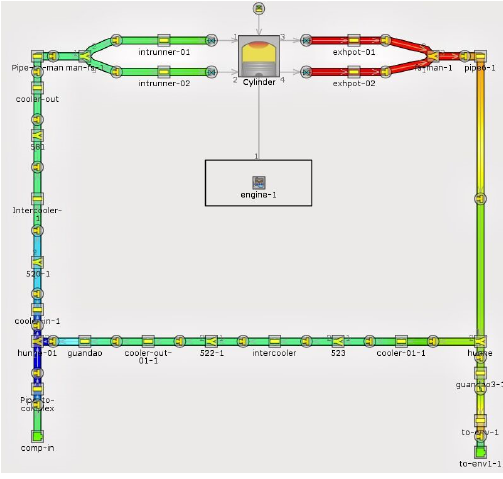
Fig. 1 Engine simulation